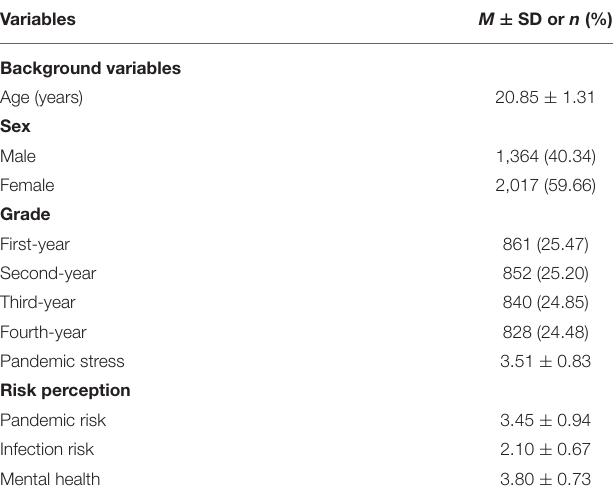
TABLE 1 | Descriptive statistics of the entire sample ( n = 3,381). TABLE 2 | Correlations between pandemic stress, risk perception, coping efficacy, and mental